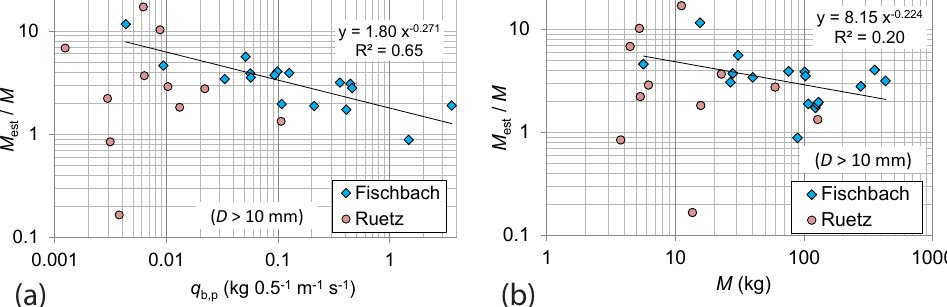
Figure 16. The estimated bedload mass per sample using the method in Wyss et al. (2016a) developed for the Erlenbach, M est , is compared with the measured bedload mass, M , through the ratio M est /M . (a) Ratio M est /M shown vs. unit bedload transport rate q b, p for particles with D > 10mm. (b) Ratio M est /M shown vs. measured bedload mass M for particles with D > 10mm. In both diagrams the regression line is based on the Fischbach data